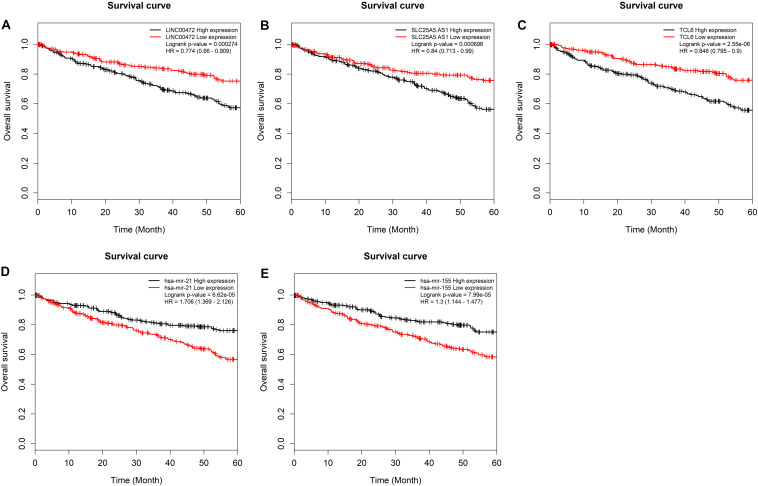
Kaplan–Meier survival curves for two miRNAs and three lncRNAs. (A) LINC00472, (B) SLC25A5.AS1, (C) TCL6, (D) miRNA-21, and (E) miRNA-155. The horizontal axis presents the survival time while the vertical axis presents the survival rate. The green curve represents the low expression group while black curve shows high expression group. MiRNAs, microRNAs; lncRNAs, long non-coding RNAs.